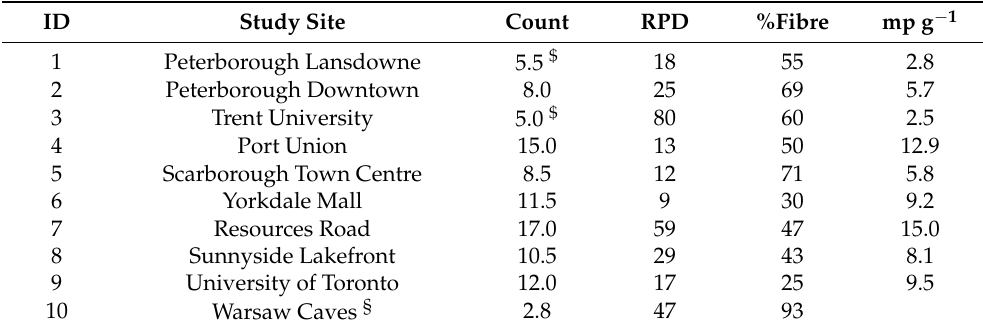
§ Variation between five control bags shown as relative standard deviation; $ microplastic counts < level of detection (LOD = 6.3 mp based on unexposed (control) moss bags from Warsaw